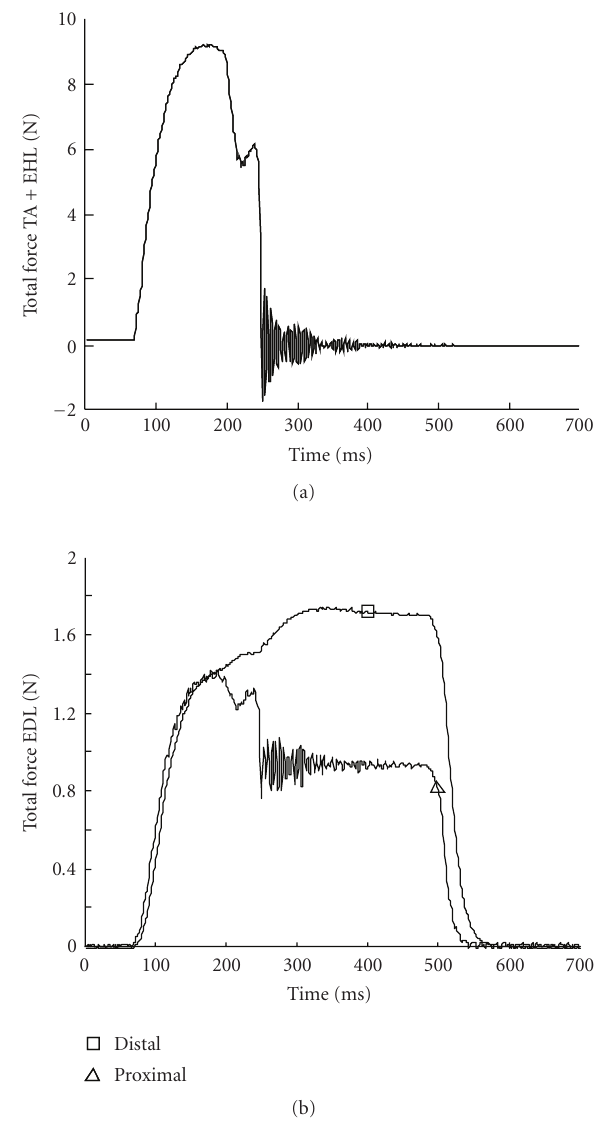
Figure 5: Waveforms of simultaneously measured force exerted at the distal tendon of TA + EHL (a) and forces exerted at the tendons of EDL muscle (b). During isometric contraction, the connection between TA + EHL and the force transducer was severed (t ∼ 200 ms). TA + EHL force dropped to zero and at the same time proximal EDL force decreased and distal EDL force increased. These results have been presented in abstract form